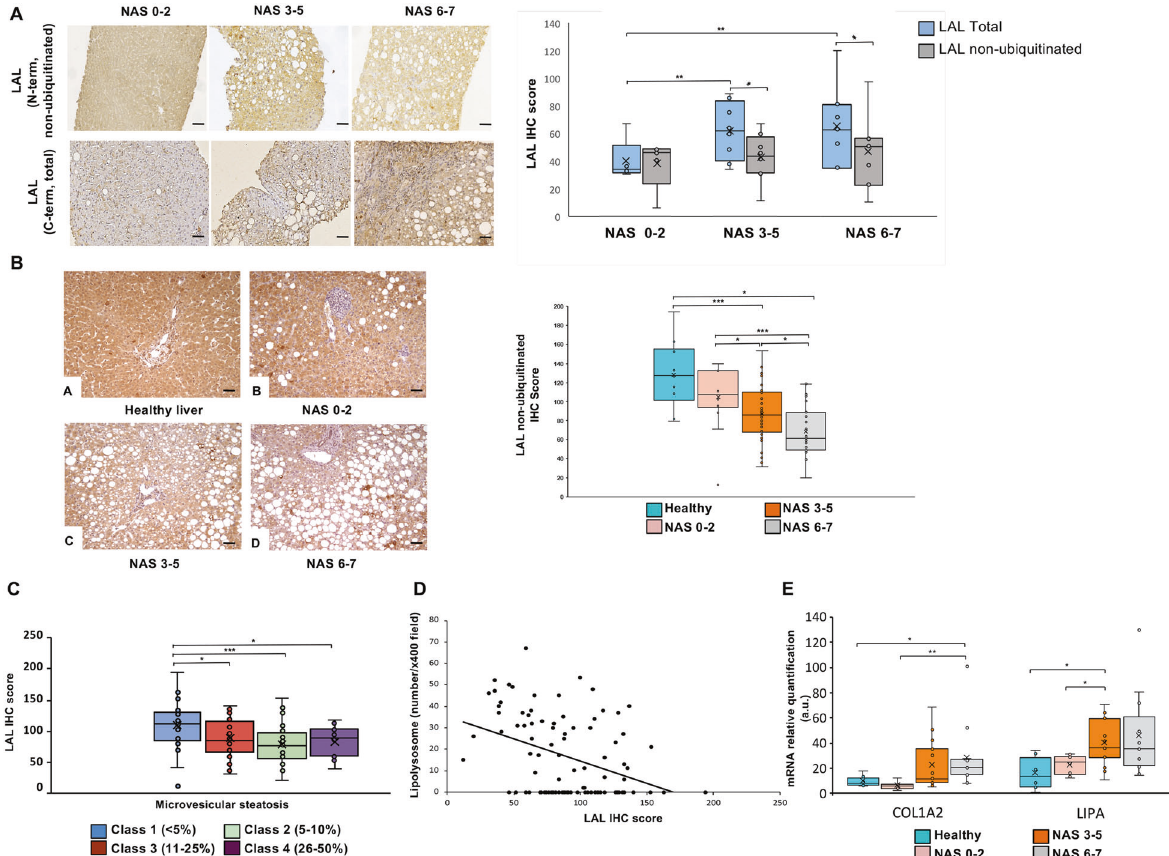
Fig. 5 LAL protein content is affected in NAFLD patient. A Immunohistochemical (IHC) analysis of LAL in 20 NAFLD patients by using different antibodies recognizing total LAL (C-term) or non-ubiquitinated LAL (N-term) (left panel) and the relative quanti fi cation (right panel). B Non-ubiquitinated LAL IHC expression was evaluated in healthy subjects ( A ) and NAFLD patients with mild (NAS 0 – 2) ( B ), moderate (NAS 3 – 5) ( C ) and severe (NAS 6 – 7) ( D ) disease activity according to NAS. LAL IHC score was lower in NAFLD patients compared to healthy livers and in moderate-severe NAS compared to mild NAS (right panel). C , D An inverse correlation between non-ubiquitinated LAL expression and the percentage of microvesicular steatosis and number of lipolysosomes was assessed. E LIPA mRNA was signi fi cantly induced in NAFLD compared to healthy subject, and correlated with NAS (Collagen1A2 was used as marker of fi brosis). Data are expressed as mean ± SD or median and 25 – 75% interquartile range (25 – 75% IR), (* p < 0.05; ** p < 0.01; *** p < 0.001). Original magni fi cation X100. Scale bar 250 μ